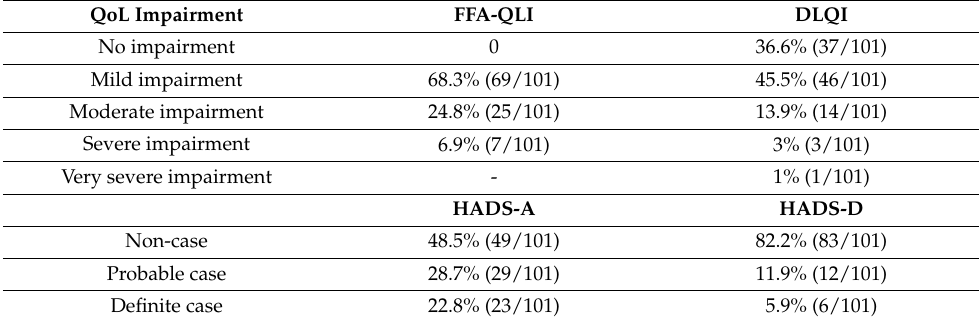
Table 2. Distribution of the scores of the questionnaires in FFA